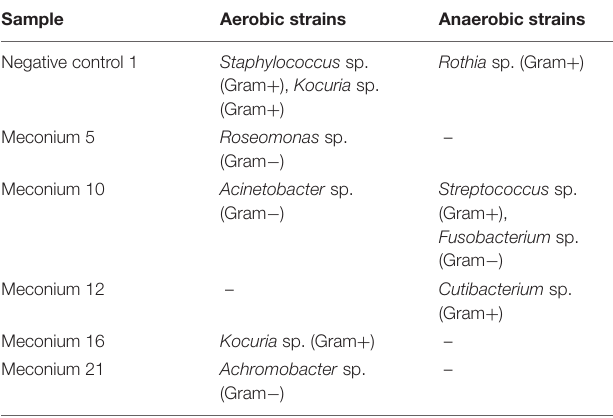
TABLE 2 | Culture positive meconium samples and identified